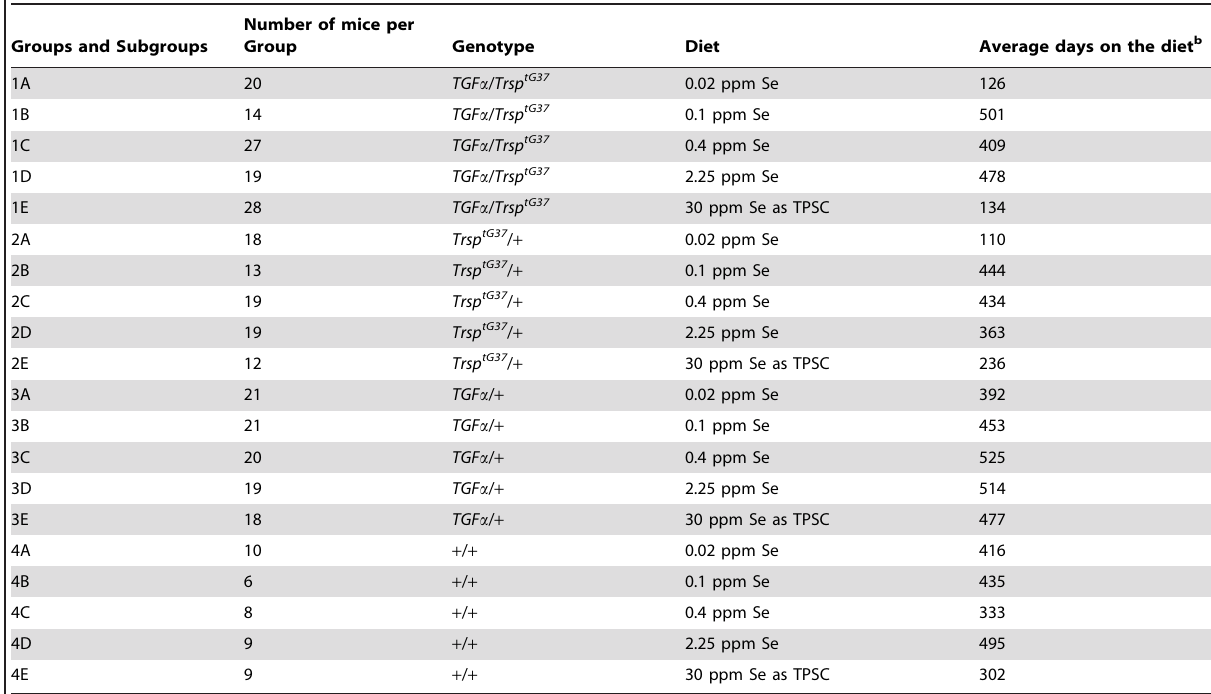
Table 1. Experimental design a .